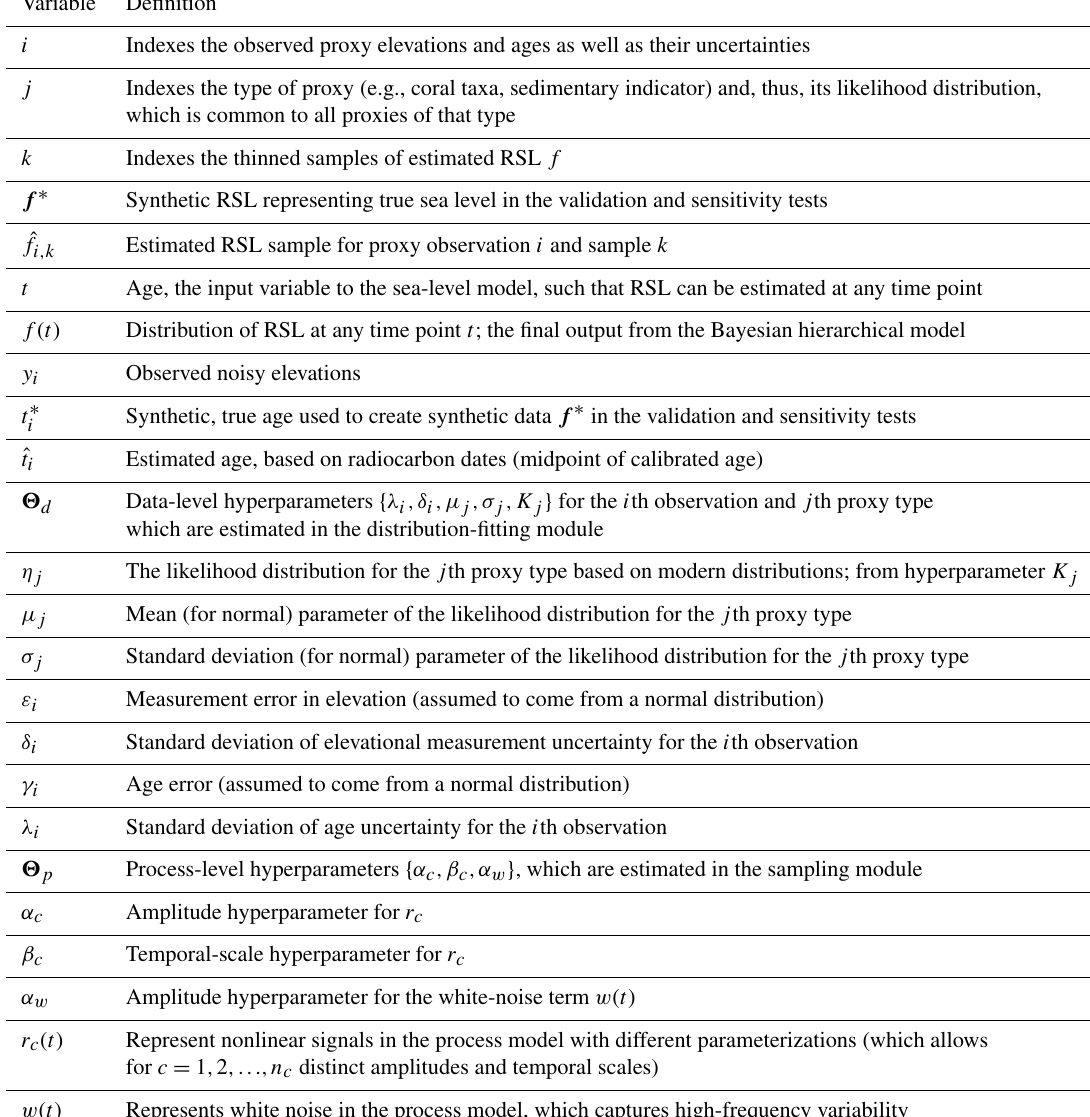
Table 1. Definitions of relevant notation in the